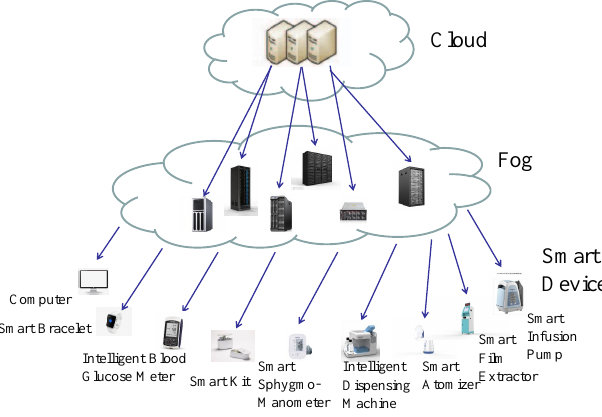
Figure 2. Three-layer